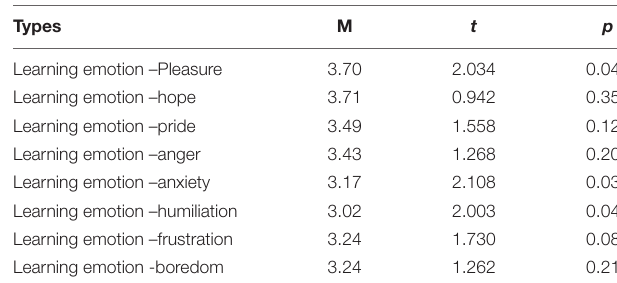
TABLE 1 | The AEQ independent sample T -test results between two